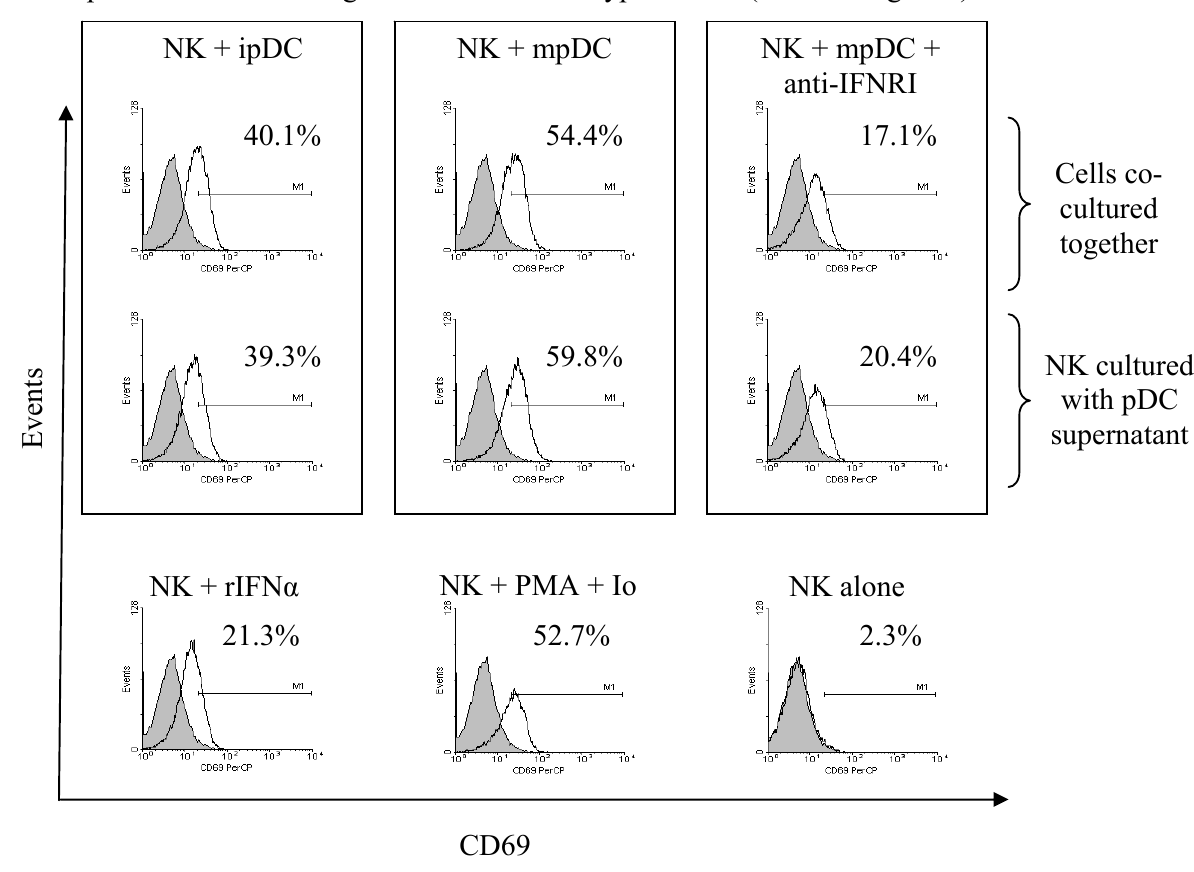
Figure 3. NK cells up-regulate CD69 in response to pDC sensitisation through secreted type I interferons. NK cells were cultured for 24 hours in the presence or absence of anti- IFNR1 antibody. Cells were cultured alone or treated with PMA/Ionomycin, rIFN α , untreated (ipDC) or CPG-treated pDC (mpDC), or their supernatants. Cells were then stained with anti-CD3, CD56, CD69 and HLA-DR antibodies and CD69 expression shown on the CD3 - CD56 + cells (clear histograms). Results from a typical experiment (total of 3) are presented with M1 region based on the isotype control (filled